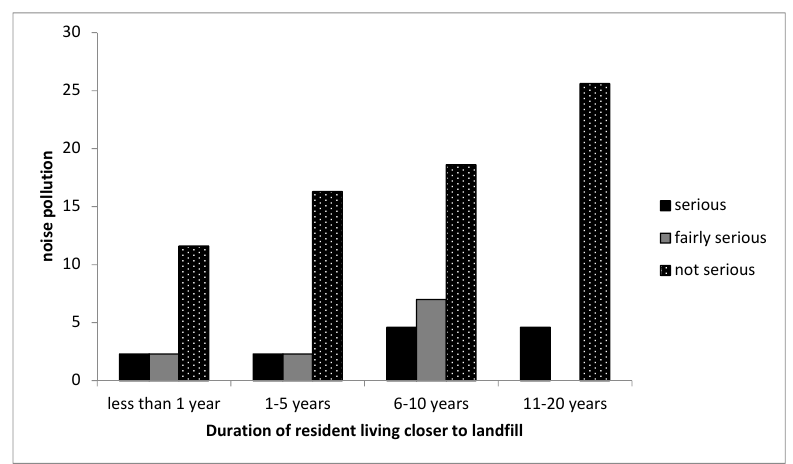
Figure 7. Cross-tabulation between the duration participants lived in the CL community and the seriousness of noise pollution. Note that the no bar section in the figure indicates there was no response by the participant.